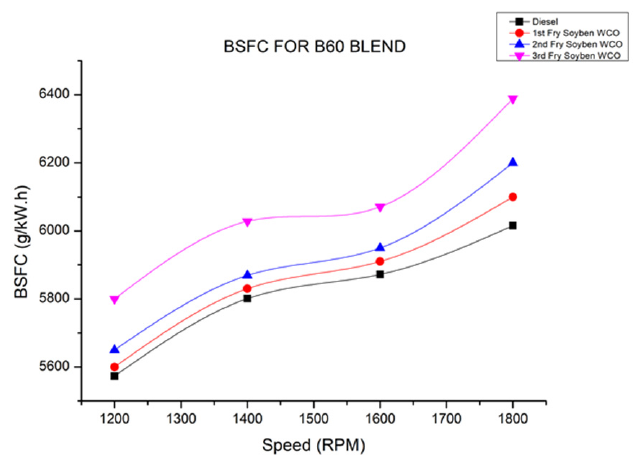
Figure 2. BSFC of different fry oils (B60 blend) at different rpm.